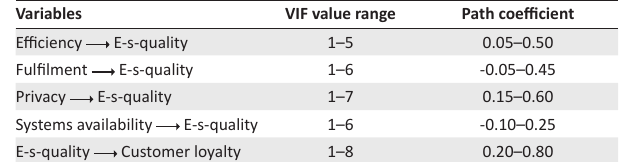
TABLE 4: Multiple regression analysis model summary for Unstructured Supplementary Service Data (USSD) banking and mobile banking app. Constructs Β Std. error of